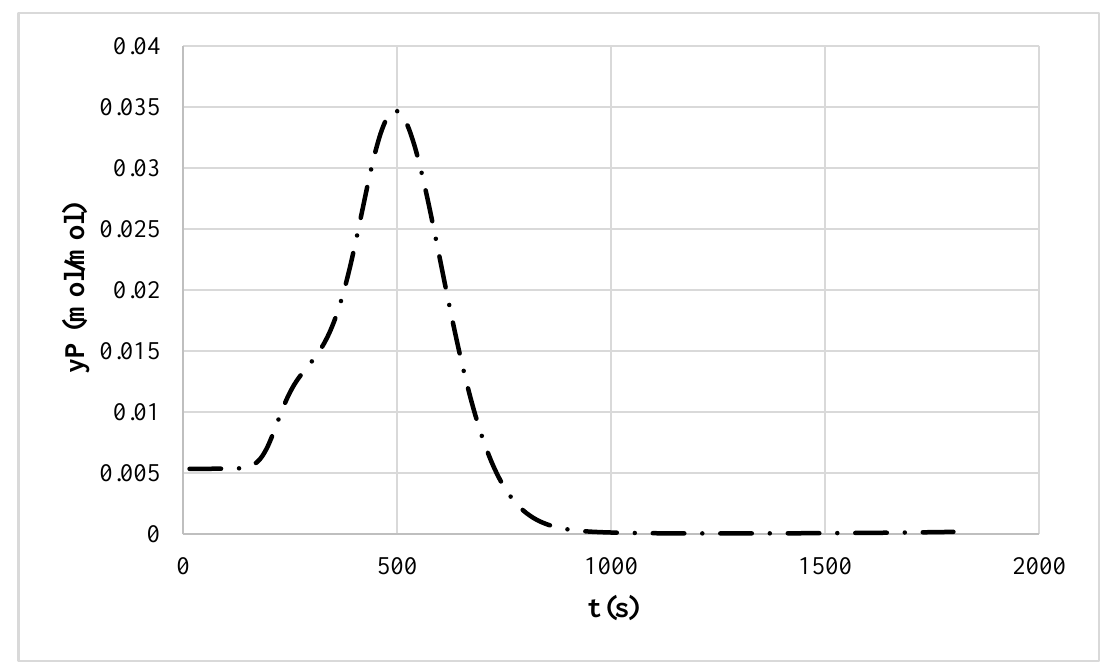
Figure 13. Pentane mole fraction in the output stream in the desorption step with time. Figure 14 shows the C6+ regeneration results. Hexane and heavier hydrocarbons were regenerated later than pentane because of their molecular weight. C6+ regeneration needed more energy, and it was also an effective parameter in the gas dew point.